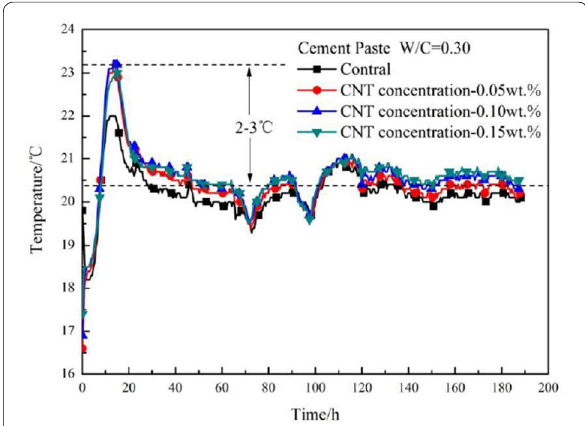
Fig. 5 Temperature curve of cement paste with CNTs.